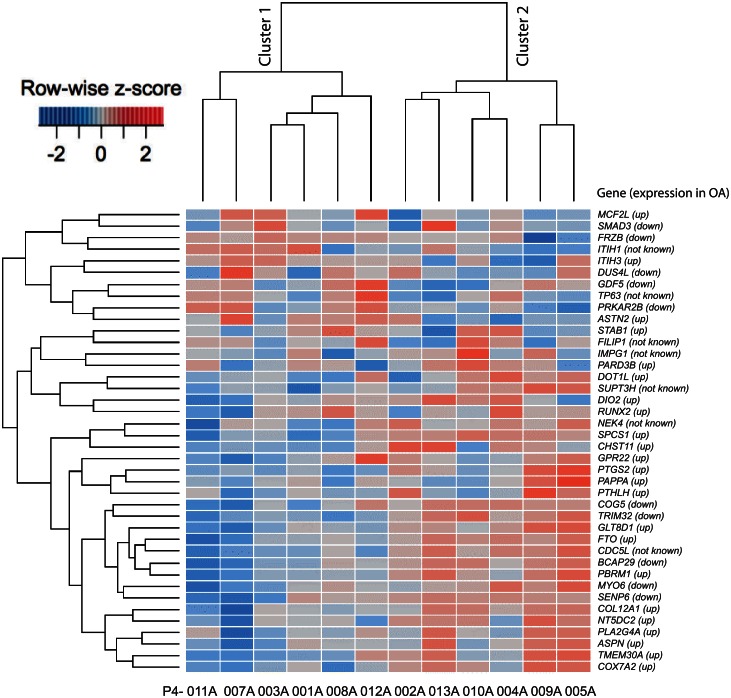
Heat map view of z-scored expression profiles of genes associated with OA risk-alleles.Hierarchical clustering identified two clusters that have distinct expression pattern. When known, the expression pattern of OA-associated genes is provided in parentheses.